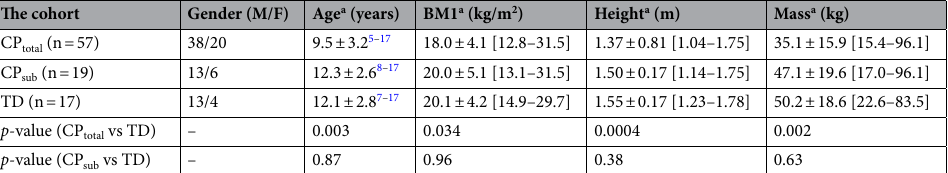
combined model to investigate the deviation of the soleus muscles of each cohort from a common mean shape. The imaging protocols of the collected MRI data used in this study are presented in Table 2. Development of statistical shape models. Variations of high-dimensional muscle morphology and appearance in CP and TD cohorts were investigated using a statistical shape modelling framework developed by Zhang et al . 20 . Each surface mesh of the data sets was defined by a shape vector S in the shape space including a specific number of surface vertices v mapped at corresponding x , y , and z coordinates across the meshes.